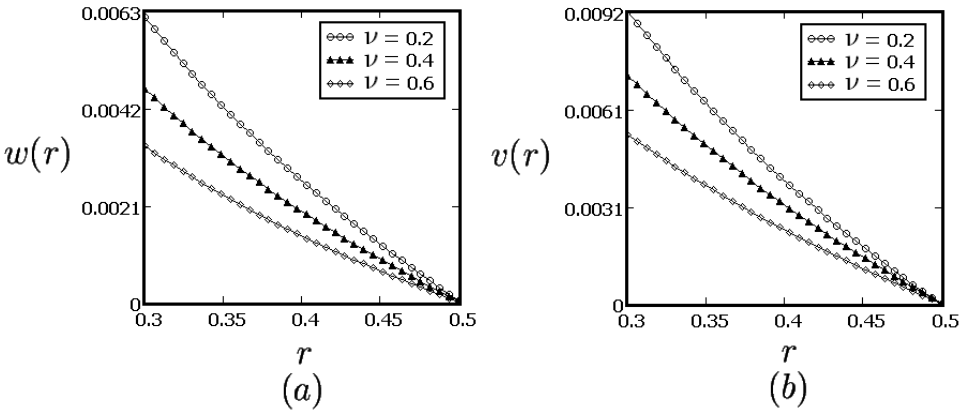
Fig. 7. Profiles of the velocity components w ( r , t ) and v ( r , t ) given by Eqs. (39), for R 1 = 0.3, R 2 = 0.5, f = g = −2, ω 1 = ω 2 = 1, ρ = 88, t = 8 s and different values of ν